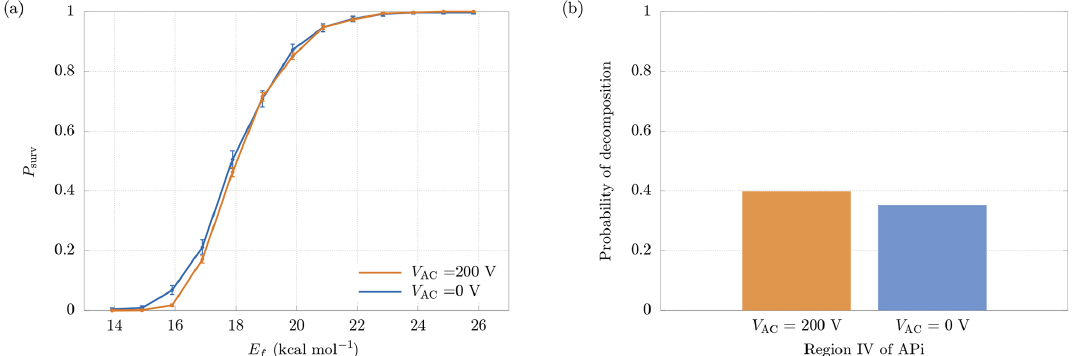
Figure 10. (a) Comparison between survival probabilities in presence ( V AC = 200V) and absence ( V AC = 0V) of the quadrupole electric field. (b) Probability of decomposition in the quadrupole region, with and without quadrupole electric field. The results are relative to the ( HSO − )( H 2 SO 4 )( HOM 10 ) cluster. 4